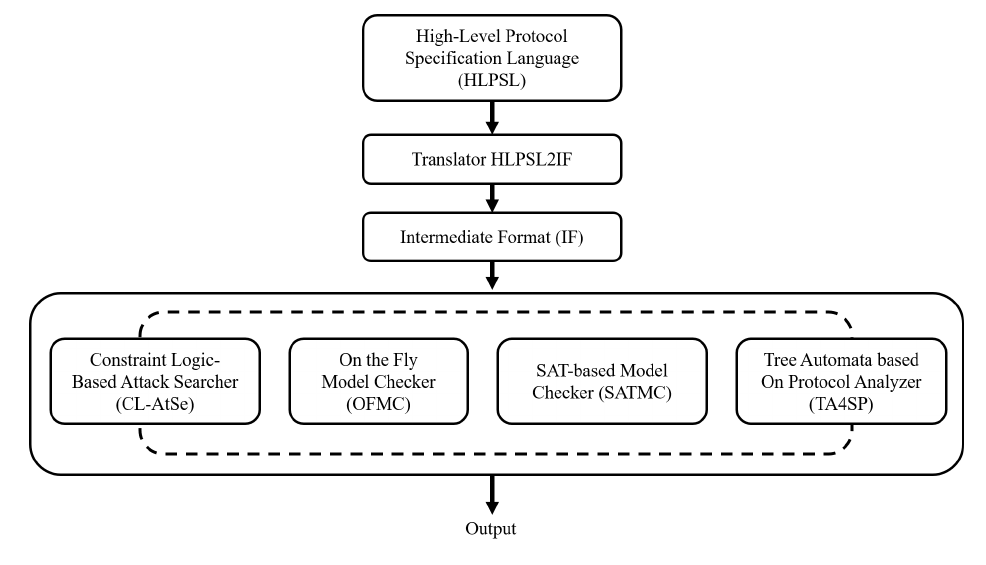
Figure 2. The Process of AVISPA Simulation.